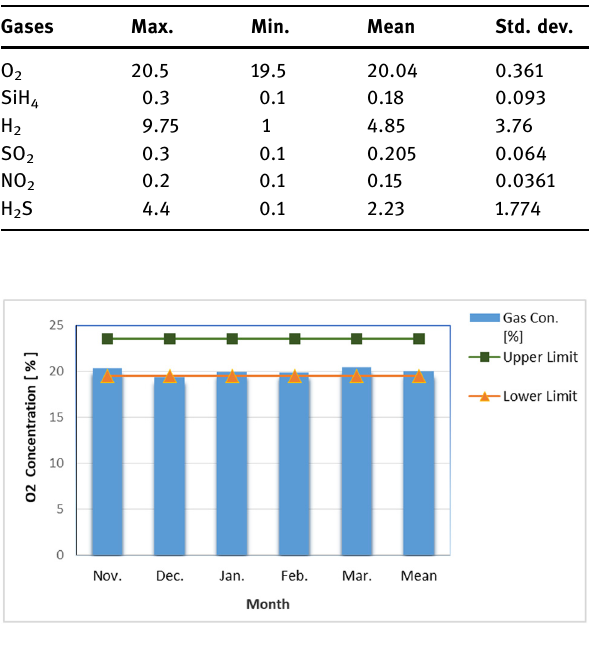
Figure 4: Monthly concentrations and overall mean of oxygen gas during the study period.